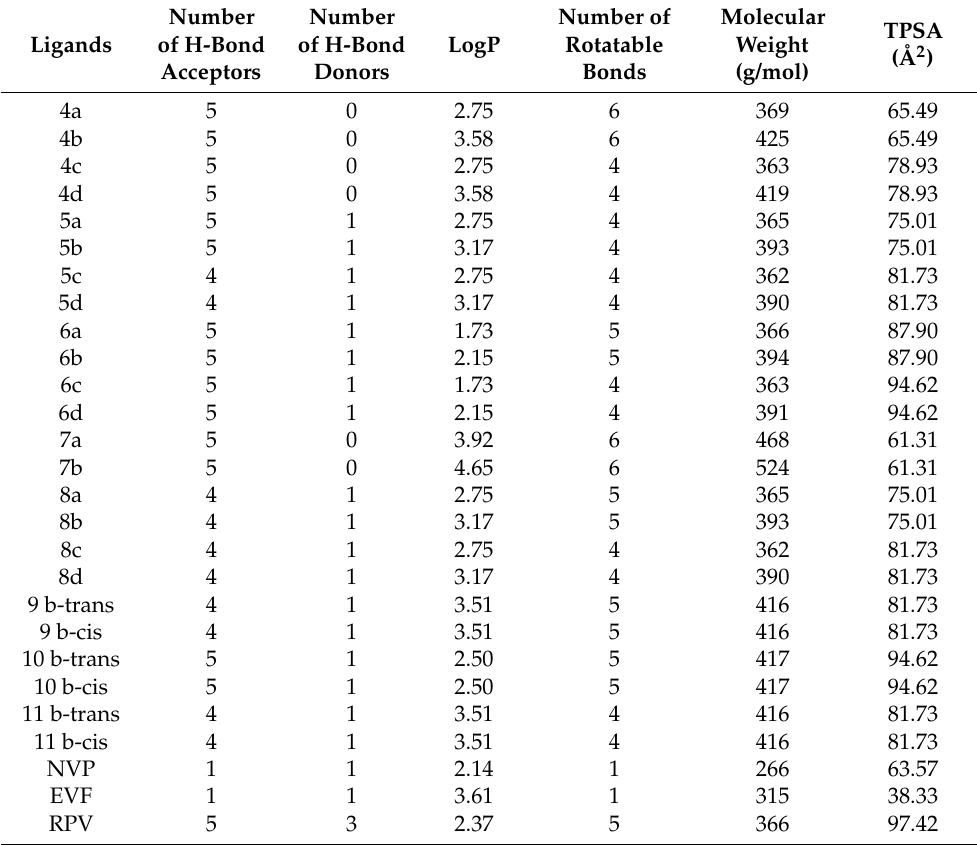
Figure 2. Overlay of the conformations of the derivatives and commercially available drugs in the binding pocket of HIV-1 RT. Table 2. Molecular properties of the derivatives and commercially available drugs calculated by SwissADME